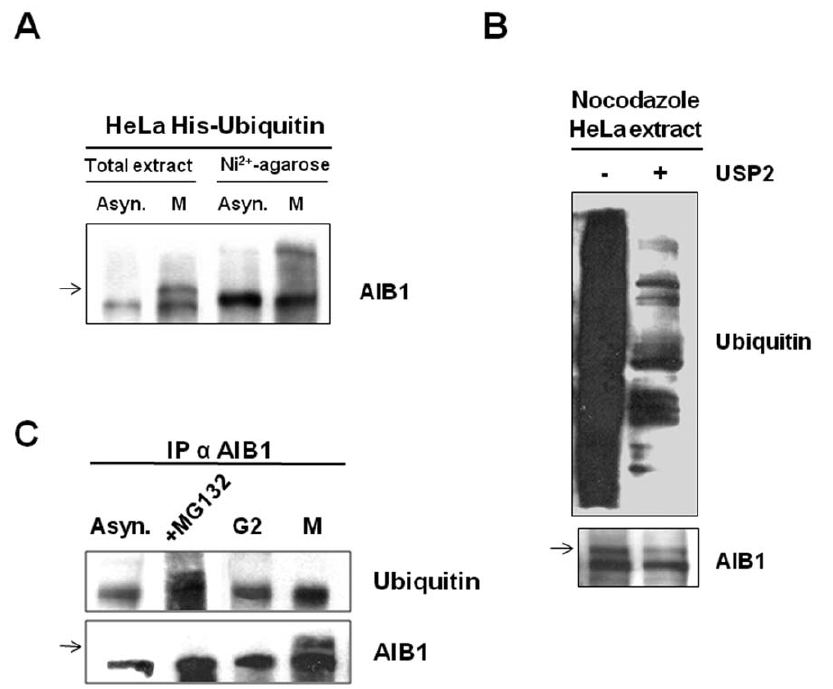
Figure 2. Post-translational modification of AIB1 at mitosis does not correlate with ubiquitination. (A) HeLa cells constitutively expressing 6xhistidine tagged-ubiquitin were grown asynchronously or arrested at mitosis with nocodazole and cell lysates were either directly analyzed (total extract) or subjected to purification through a Ni 2 + -agarose column and further analyzed by western blotting. Arrow indicates the AIB1 mitotic-specific band. (B) MCF-7 cell extracts (30 m g, 1:100) from arrested cells with nocodazole were subjected to enzymatic assay with the 300 ng of deubiquitinating enzyme GST-USP2 in 50 m l deubiquitylation buffer (50 mM Tris-HCl pH 7.5, 1 mM EDTA, 1 mM DTT). Samples were analyzed by western blot with anti-mono, poly-ubiquitin antibodies and anti-AIB1 antibodies. The altered electrophoretic mobility of the AIB1 band is indicated with an arrow, demonstrating insensitivity to USP2 activity. (C) HeLa cells were grown asynchronously, or treated with the proteasome inhibitor MG132, or with etoposide to arrest them at G2 or with nocodazole to arrest them at mitosis (M). Cell lysates were immunoprecipitated with AIB1 antibodies and immunocomplexes were analyzed by western blotting with anti-mono, poly-ubiquitin antibodies and anti-AIB1 antibodies. The arrow indicates the mitosis-specific AIB1 band that is not detected with ubiquitin antibodies.